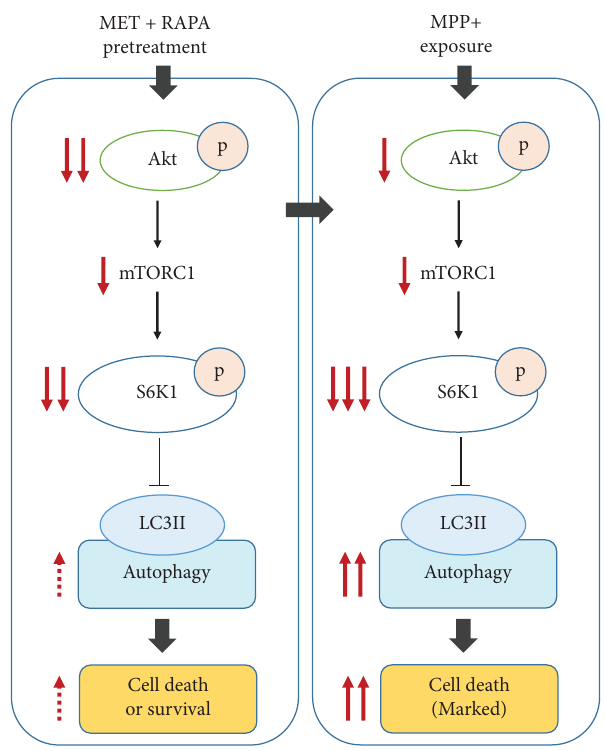
Figure 6: Schematic of the Akt/S6K1 pathway in the modulation of autophagy in MPP + -treated neuronal cells pretreated with MET and RAPA combination. SH-SY5Y cells were treated with 10 μ M RA for 10days for neuronal diferentiation before exposure to MET and RAPA. Te number of red arrows indicates the strength of the